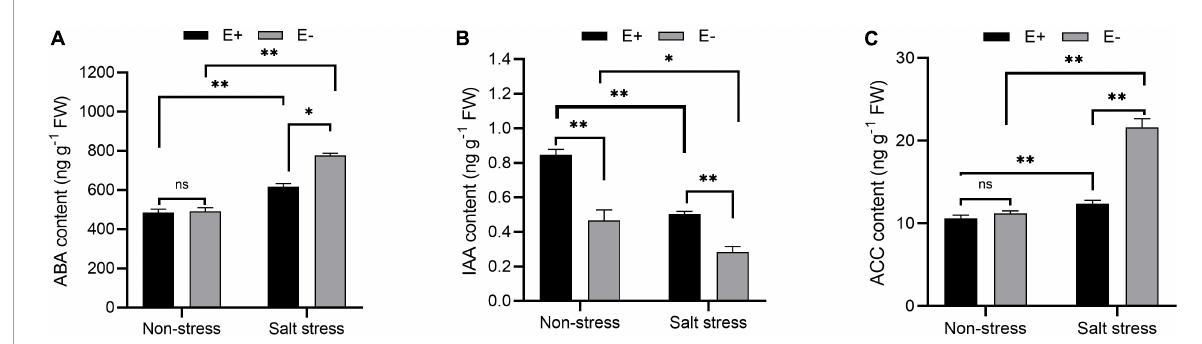
FIGURE5 Changes in endogenous hormone content. Abscisic acid (ABA) (A) , indole acetic acid (IAA) (B) and 1-aminocyclopropane-1-carboxylate (ACC) (C) contents of bermudagrass with inoculated and uninoculated plants under salt stress. Bars denote means ± SE of four treatment. “Non-stress” represents bermudagrass grown without NaCl condition; “Salt stress” represents bermudagrass under 250 mM salt conditions. “E + ” represents the infection of Enterobacter ludwigii , “E − ” represents the absence of E. ludwigii. “ ∗ ,” “ ∗∗ ,” indicate significant differences at P < 0.05, and P < 0.01, respectively, and ‘ns’ represents no significant difference.